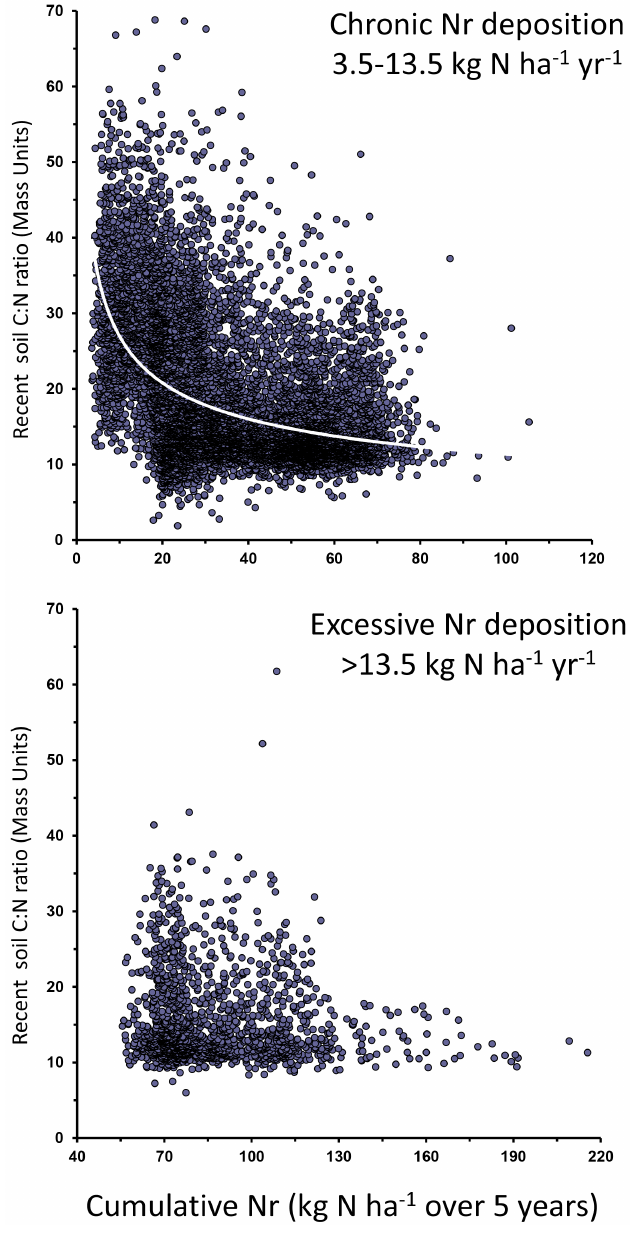
Figure 3. Cumulative Nr deposition of the last 5 years prior to sam- pling and soil C:N ratios: negative power functions of soil C:N ratios in nature (measured in 2009) as predicted by cumulative Nr deposition. Upper panel: 9888 unmanaged sites belonging to the cluster with low Nr load but chronic exposure to nitrogen (Depo- sition Cluster VI); lower panel: 1546 unmanaged sites under ex- cessive Nr load (Deposition Cluster VII). This last cluster acts as a kind of envelope which incorporates sites with low soil C:N ratios. We were not able to extract a significant deposition effect for man- aged ecosystems although long-term inverse relationships between Nr and soil C:N hold (see Table